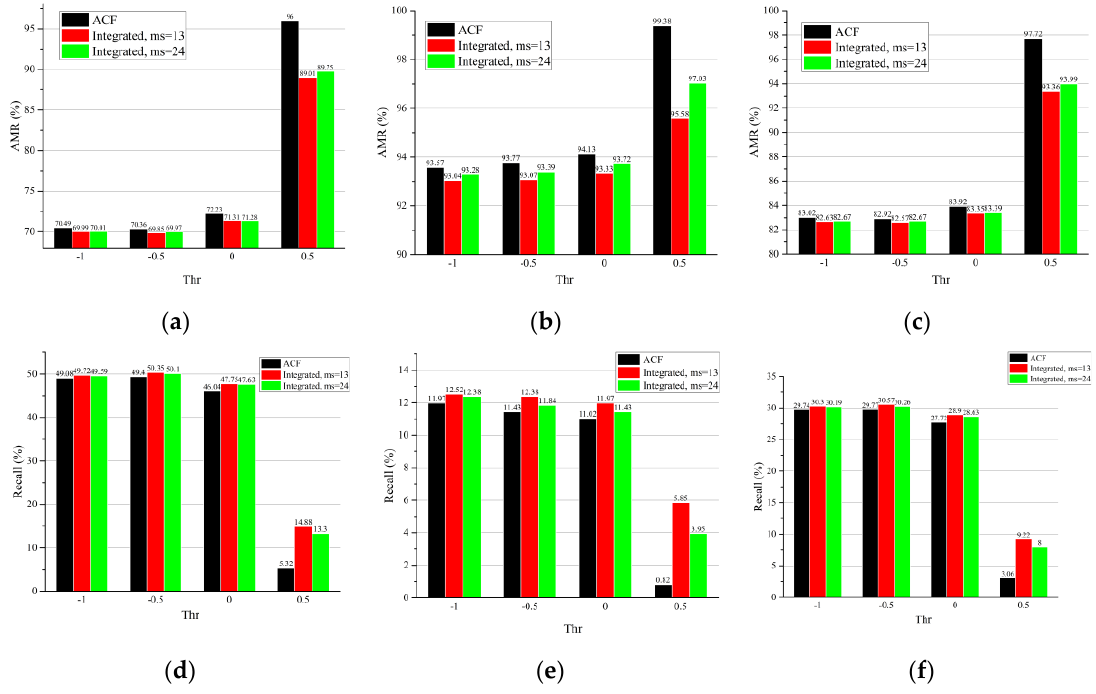
Figure 23. The AMR and recall of the reasonable subset ( a , d ), heavily occluded subset ( b , e ), and all subset ( c , f ) for the the Citypersons validation set. The ACF detector was pretrained on the Caltech dataset.